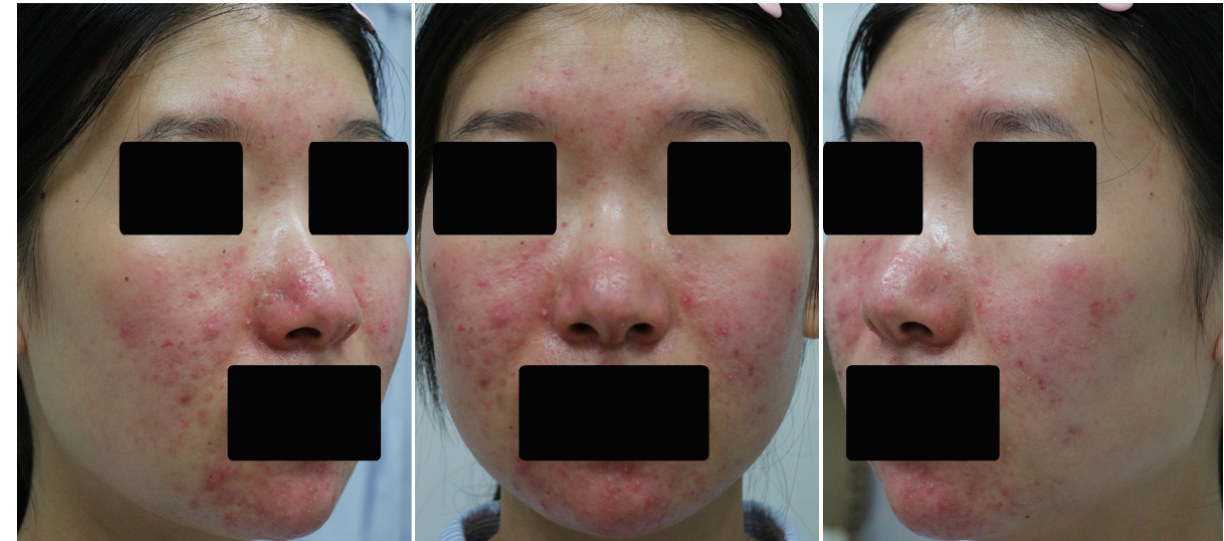
Figure 1. Examples of 3 photos taken from 3 different angles for each